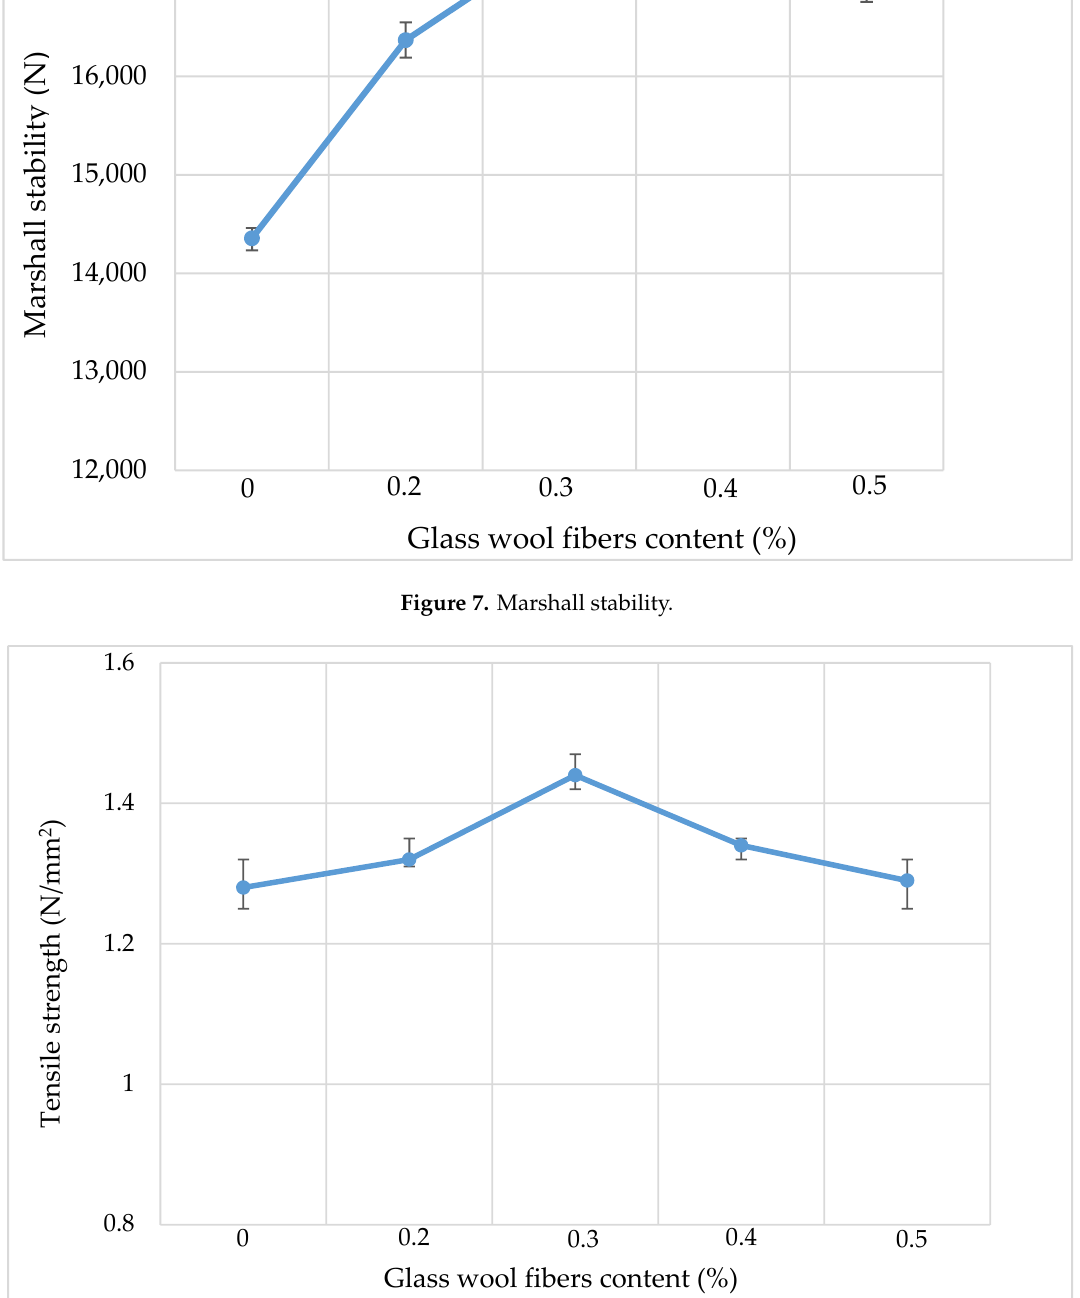
Figure 9. Toughness results .